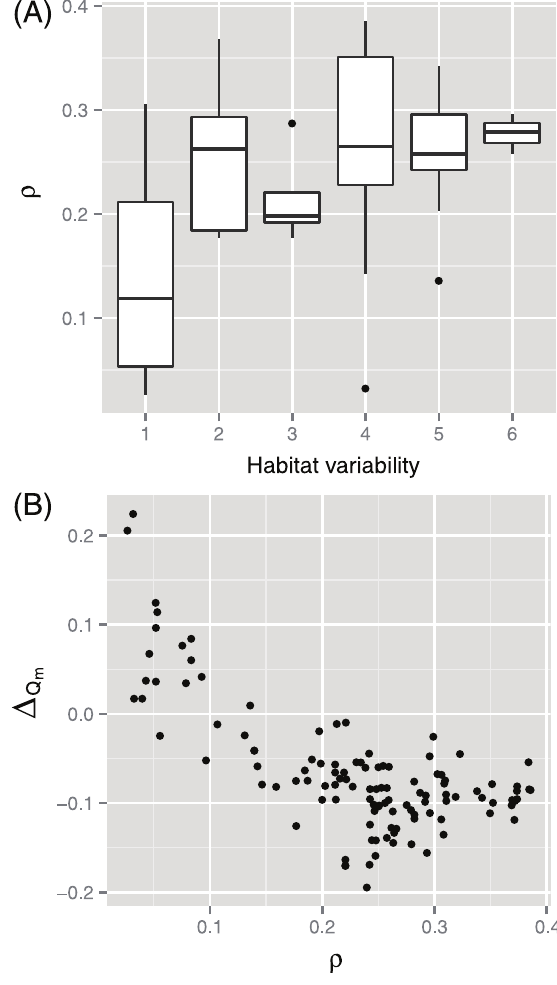
Figure 5. Ratio r of the number of new edges among nodes in the earlier version of the database to all newly added edges. (A) The ratio r depends on habitat variability ( p =6.8 6 10 2 8 using the Kruskal-Wallis test). (B) The ratio r negatively correlates with the difference D Qm (Spearman’s rank correlation coefficient r s = 2 0.56 and p =1.0 6 10 2 10 ).